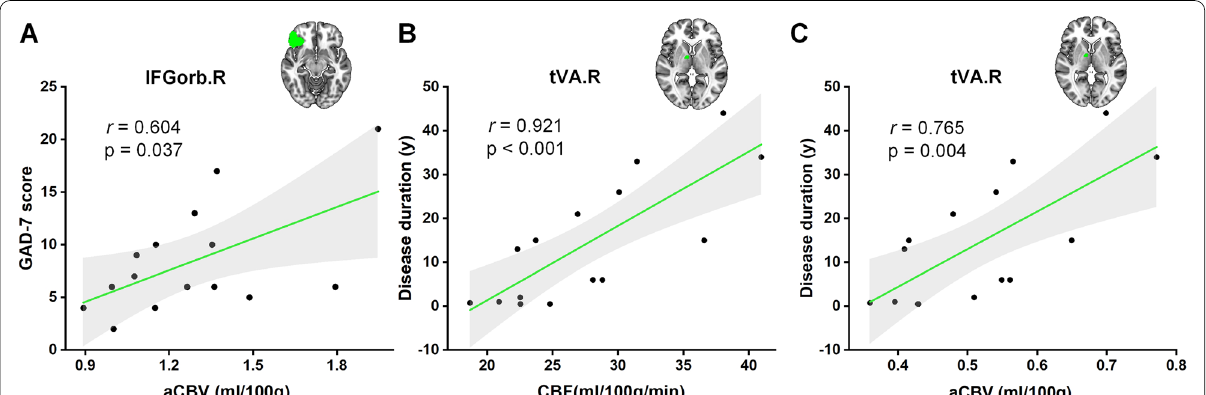
Fig. 5 Correlation analysis between cerebral perfusion parameters and clinical variables in brain regions with significant differences of NDPH. The aCBV of the right inferior frontal gyrus pars orbitalis (IFGorb.R) was positively correlated with the GAD-7 score ( A ). The CBF of the right thalamus, ventral anterior nucleus (tVA.R) was positively correlated with disease duration ( B ), as well as the aCBV of tVA.R ( C ). NDPH new daily persistent headache, aCBV arterial cerebral blood volume, CBF cerebral blood flow, GAD-7 Generalized Anxiety